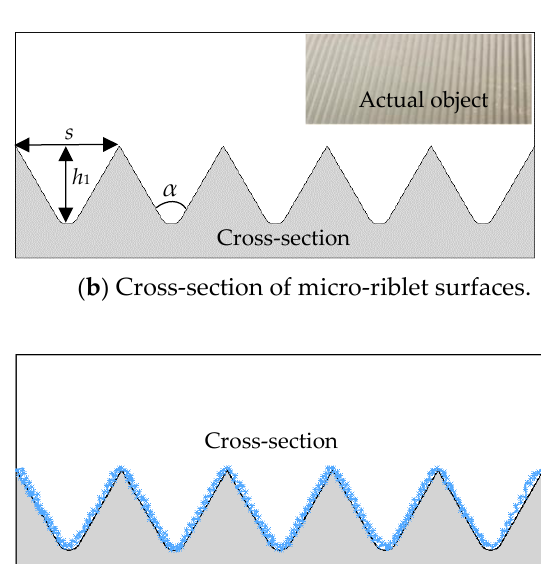
( a ) Electron microscope scanning image of superhydrophobic surface.